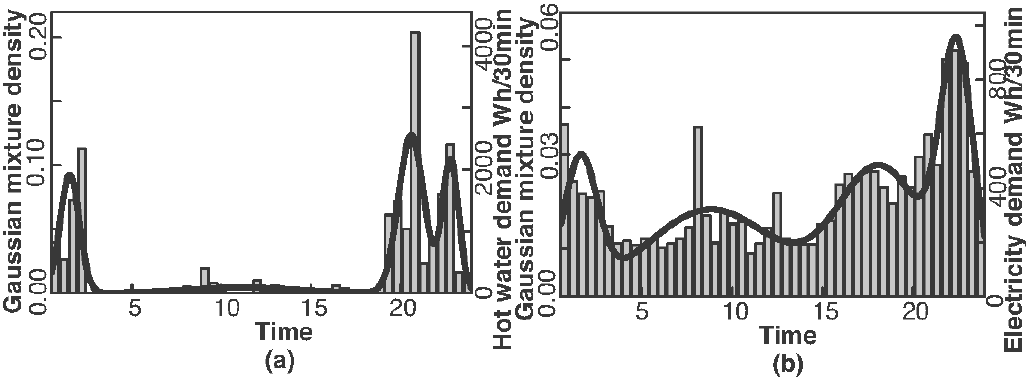
Figure 3. A sample fitting of the Gaussian mixture model. ( a ) Hot water demand; ( b ) electricity